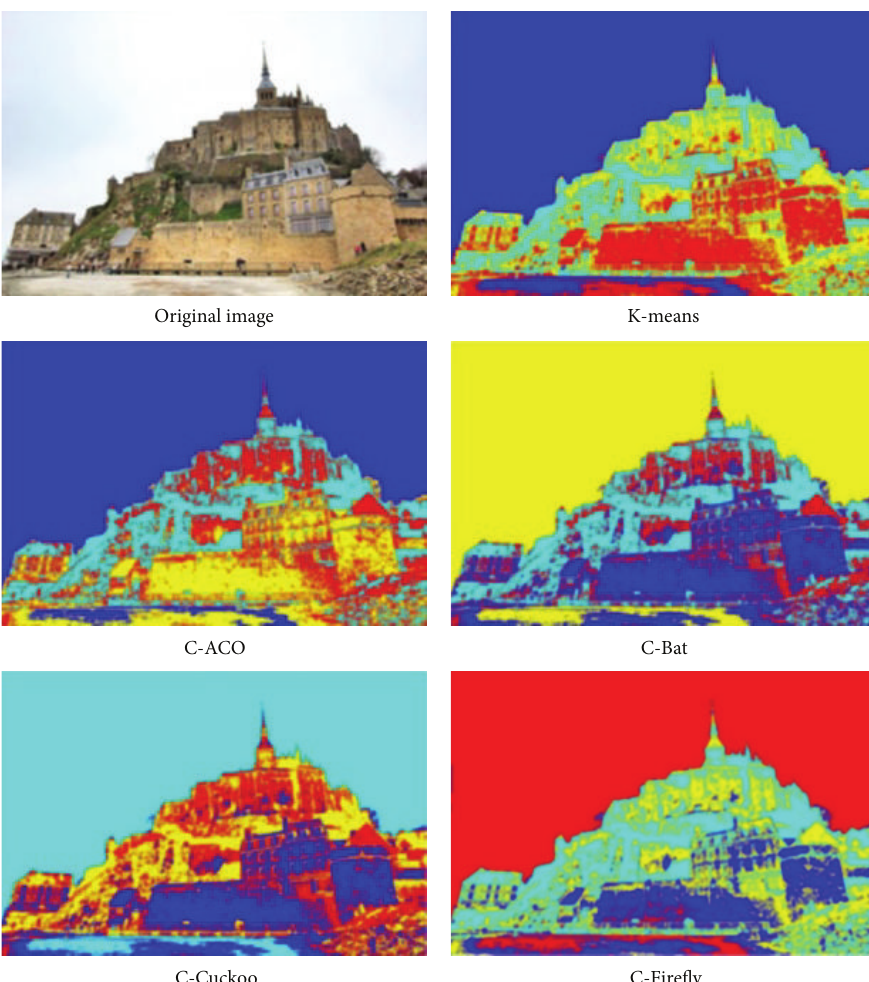
Figure 11: Results of image segmentation by using different nature-inspired clustering algorithms, on a photo called “Le